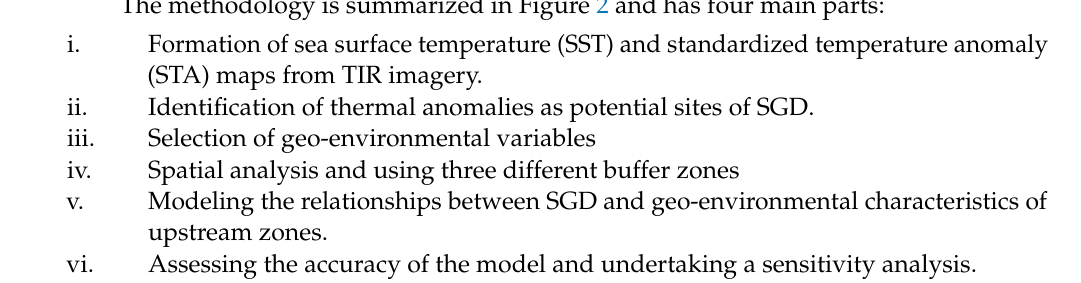
Figure 1. Location map of the study area in the south of Iran. Field photographs of some SGD oc- currences in the study area: ( a ) Shif-Hendijan, and ( b ) Naiband #1.